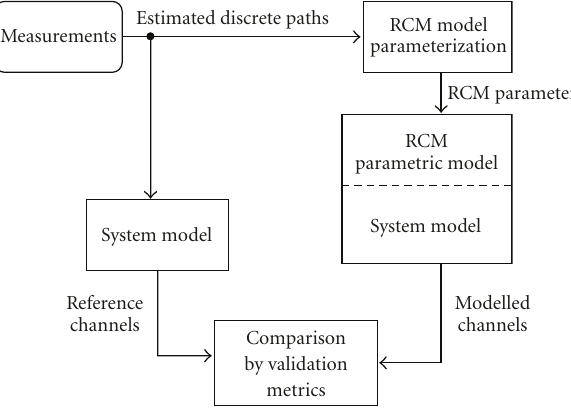
Figure 4: Validation